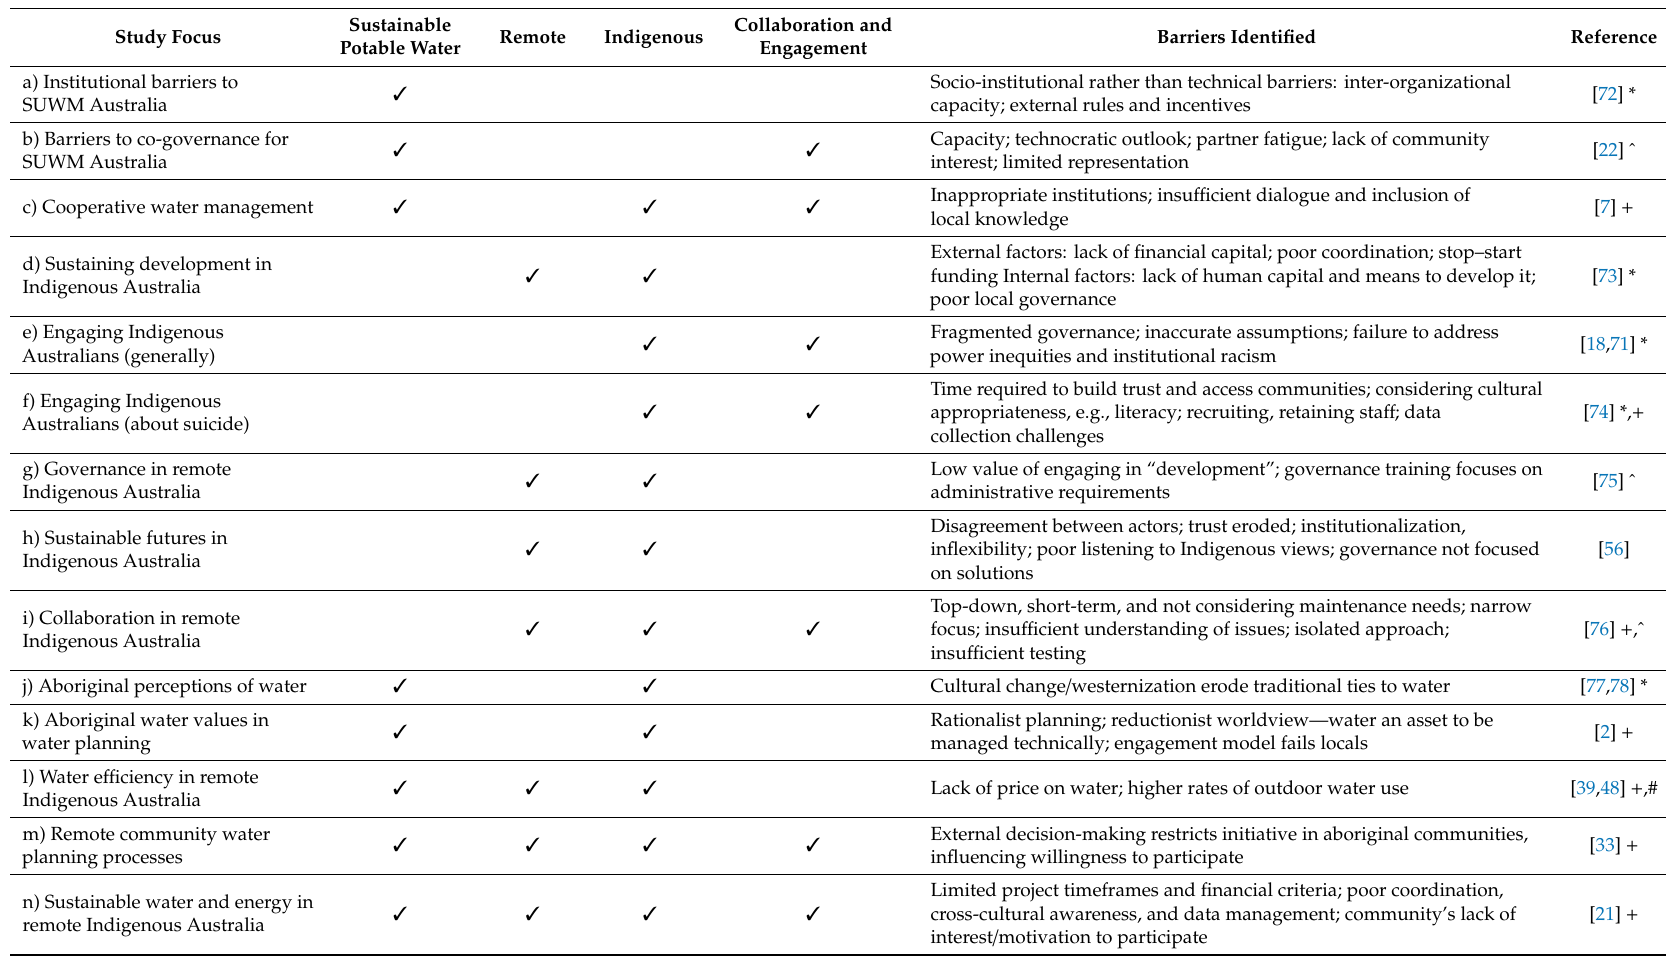
Barriers Identified